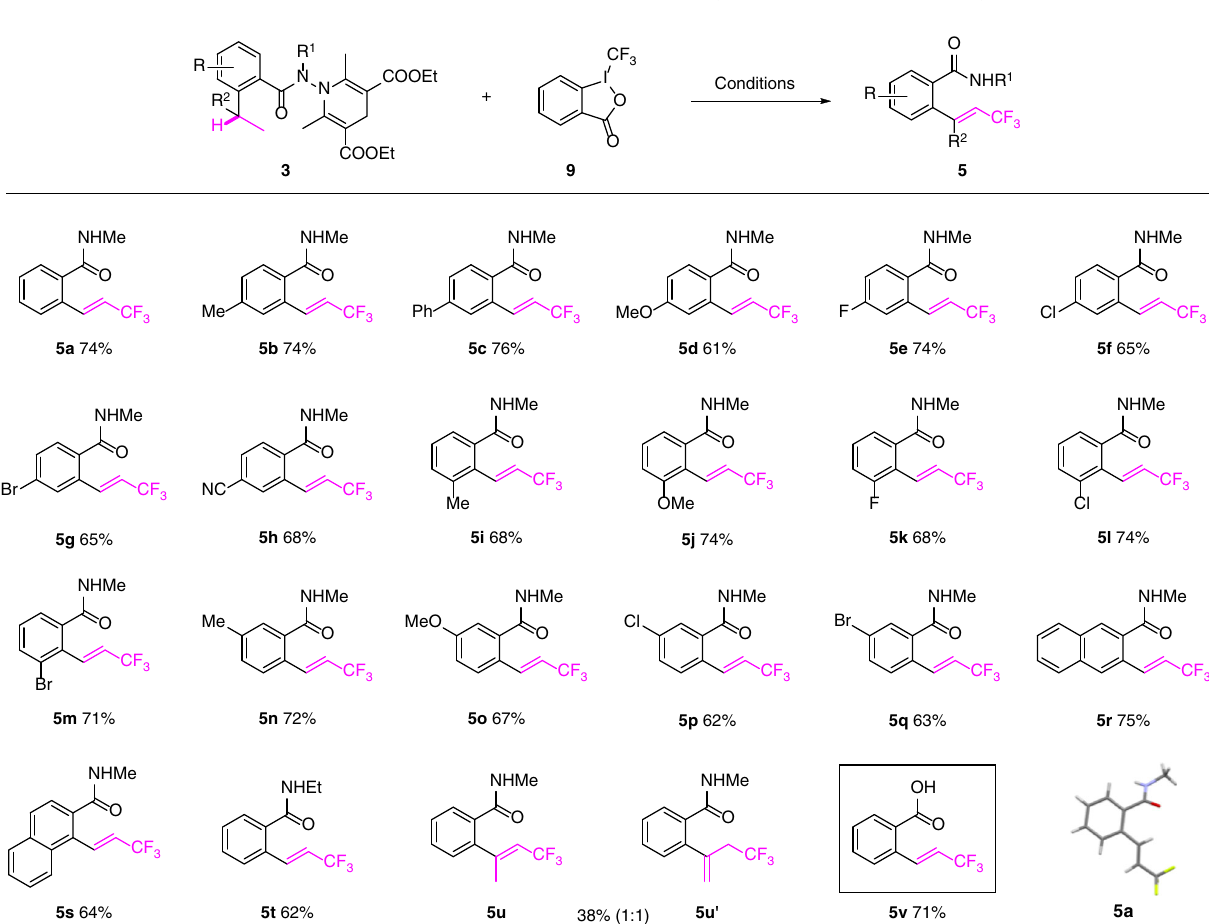
Fig. 4 Oxidative δ -tri fl uoromethylation of 2-alkyl benzohydrazides. 3 (0.1 mmol), Togni ’ s reagent 9 (0.3 mmol), CuCl (0.04 mmol), DCM (1.0 mL), Na 2 CO 3 (0.3 mmol), rt, 4